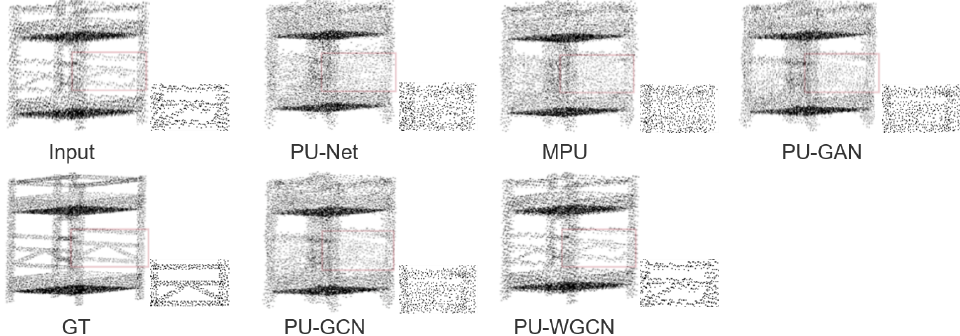
Figure 12. Upsampling visualization results of group b. Compared to the previous method, our upsampling boundary is clearer. PU-WGCN keeps the boundary information of objects